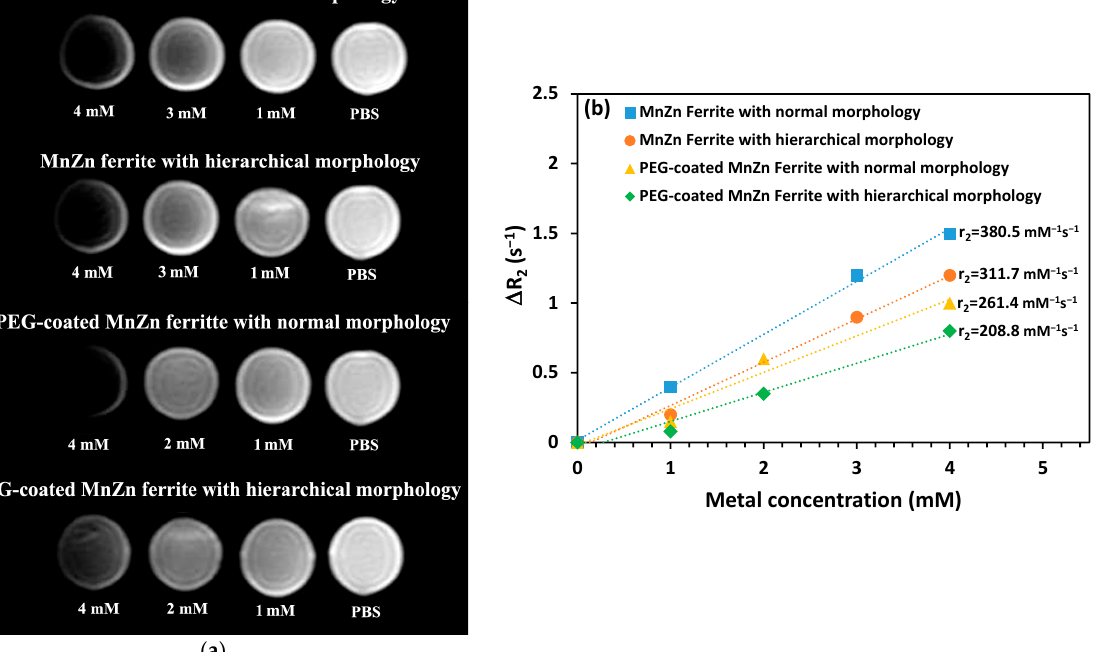
Figure 9. Effect of nanoparticle concentration on ( a ) in vitro T 2 -weighted MR images of PBS media containing PEG-coated and uncoated nanopowders with different morphologies, and ( b ) T 2 relaxation rate against metal (i.e., Mn + Zn + Fe) concentration for the PEG-coated and bare MnZn ferrite NPs dispersions with di ff erent morphologies.